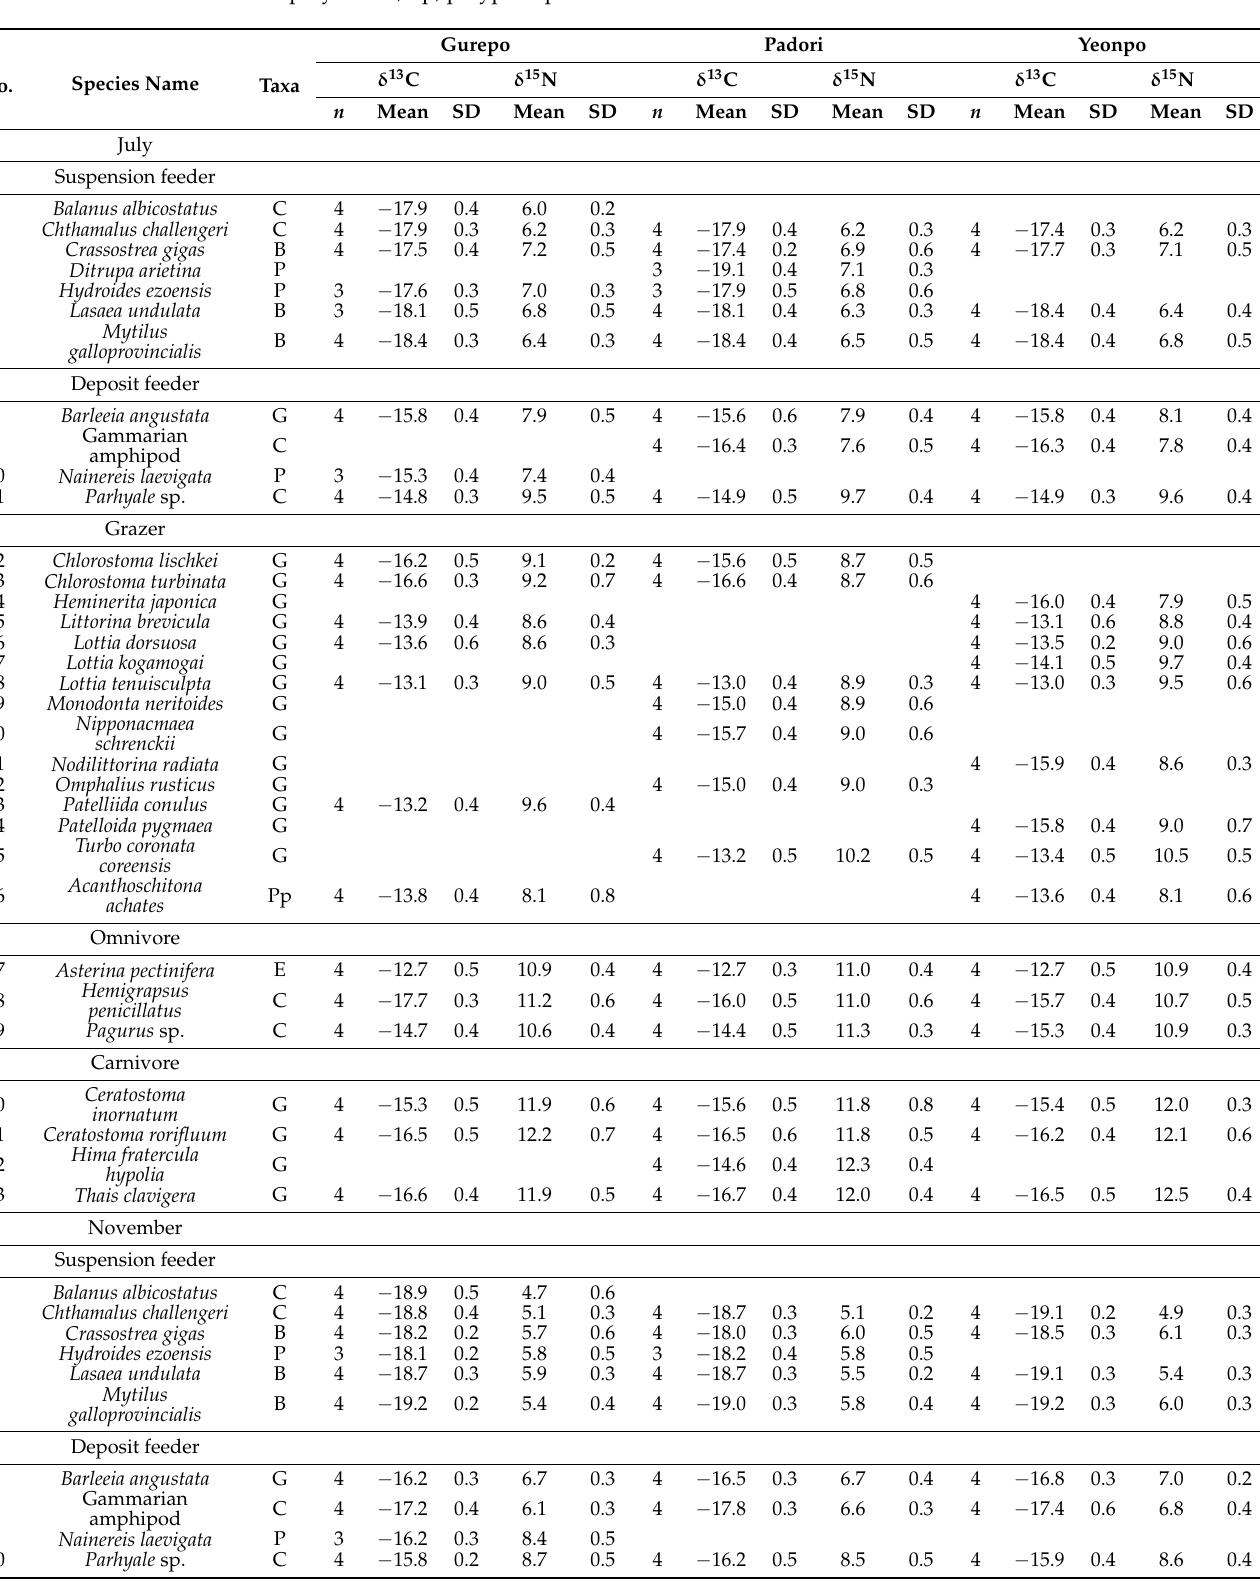
Table 2. Mean δ 13 C and δ 15 N values of macrobenthic consumers collected at the two heavily oil- impacted (Gurepo and Padori) and one non-impacted reference (Yeonpo) sites in July and November. Data represent means ± 1 SD. Taxa: B, bivalvia; C, crustacea; E, echinodermata; G, gastropoda; P, polychaeta; Pp,